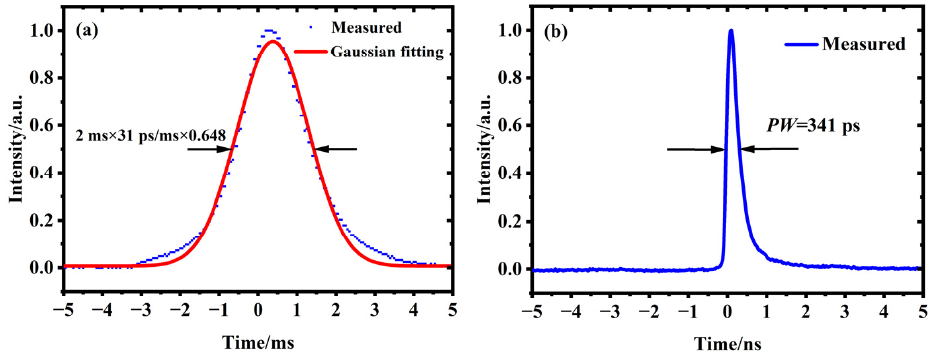
Figure 3. Temporal pulse profile of ( a ) before and ( b ) after broadening.